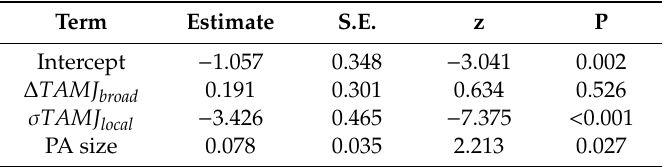
Table 3. Results of generalized linear mixed modelling (GLMM; assuming Gaussian errors) of bird density change in PAs. Bird density was modelled using change in broad-scale air temperatures ( ∆ TAMJ broad ), local air temperature variability ( σ TAMJ local ) and PA size as predictors. Forest proportion was an o ff set variable in the analysis. The protected area size was log-transformed prior to the analysis. Term Estimate S.E. z P Intercept − 1.057 0.348 − 3.041 0.002 ∆ TAMJ broad 0.191 0.301 0.634 0.526 σ TAMJ − 3.426 0.465 − 7.375 < 0.001 local PA size 0.078 0.035 2.213